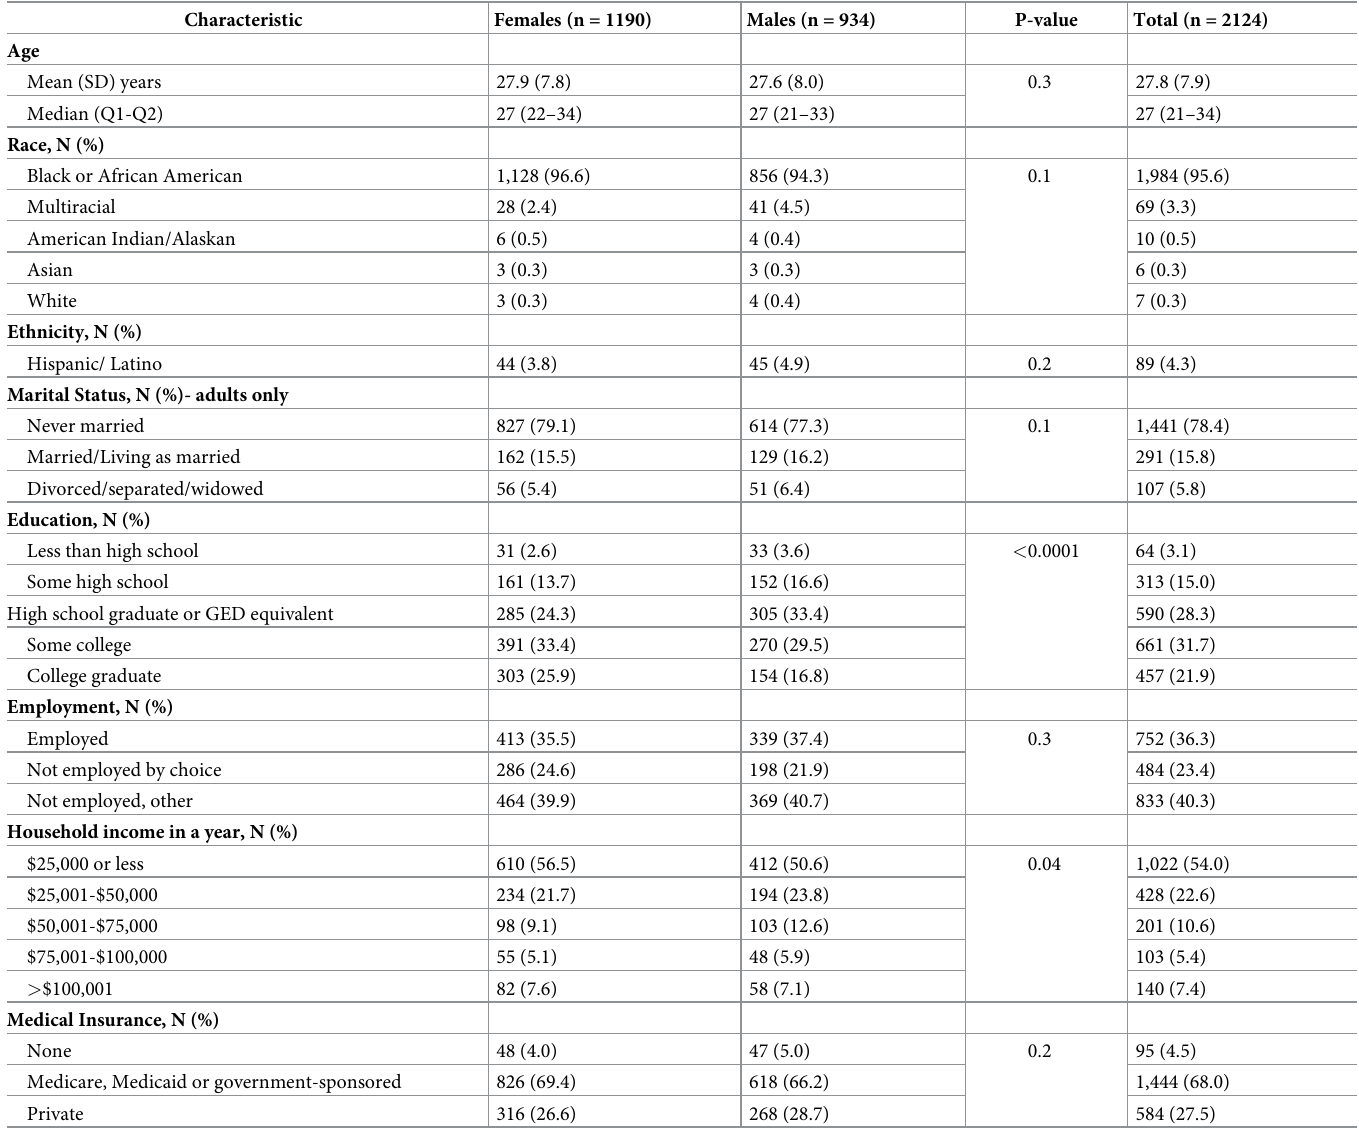
Table 1. Participant socio-demographic